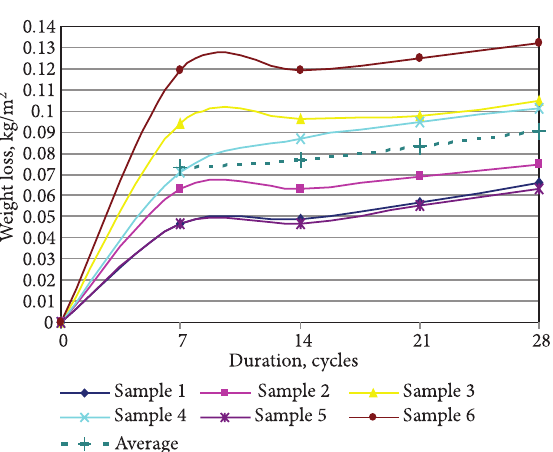
Fig. 6. Weight loss in hardened cement paste with 10 wt% SZ